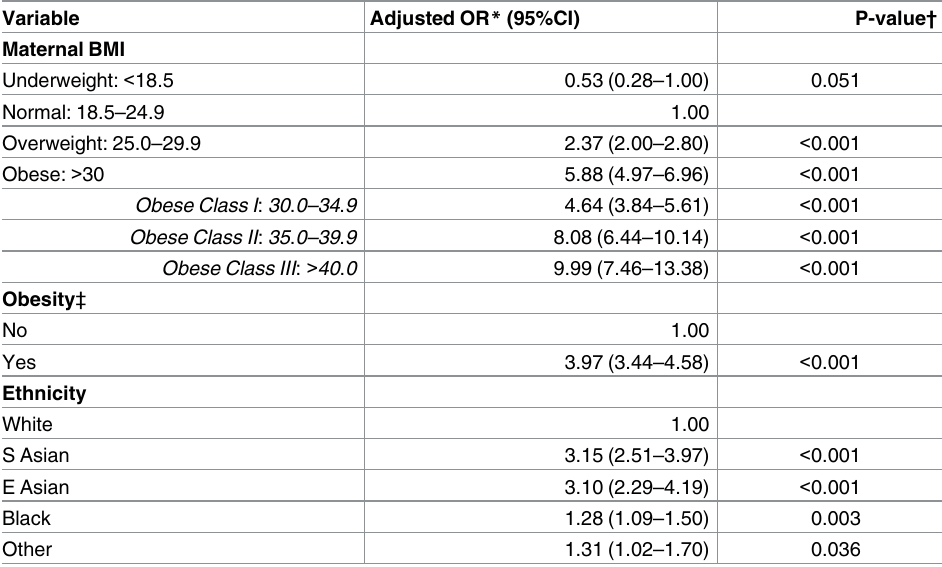
Table 2. Multivariate analysis of factors associated with diabetes in